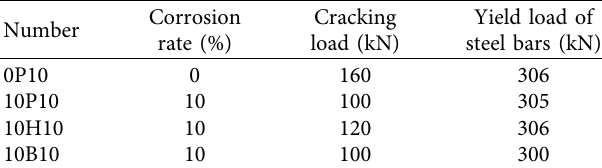
Table 4: Ultimate bearing capacity and deflection of